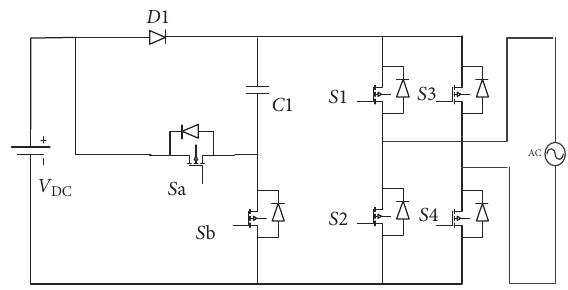
Figure 1: Detailed switched-capacitor multilevel inverter.